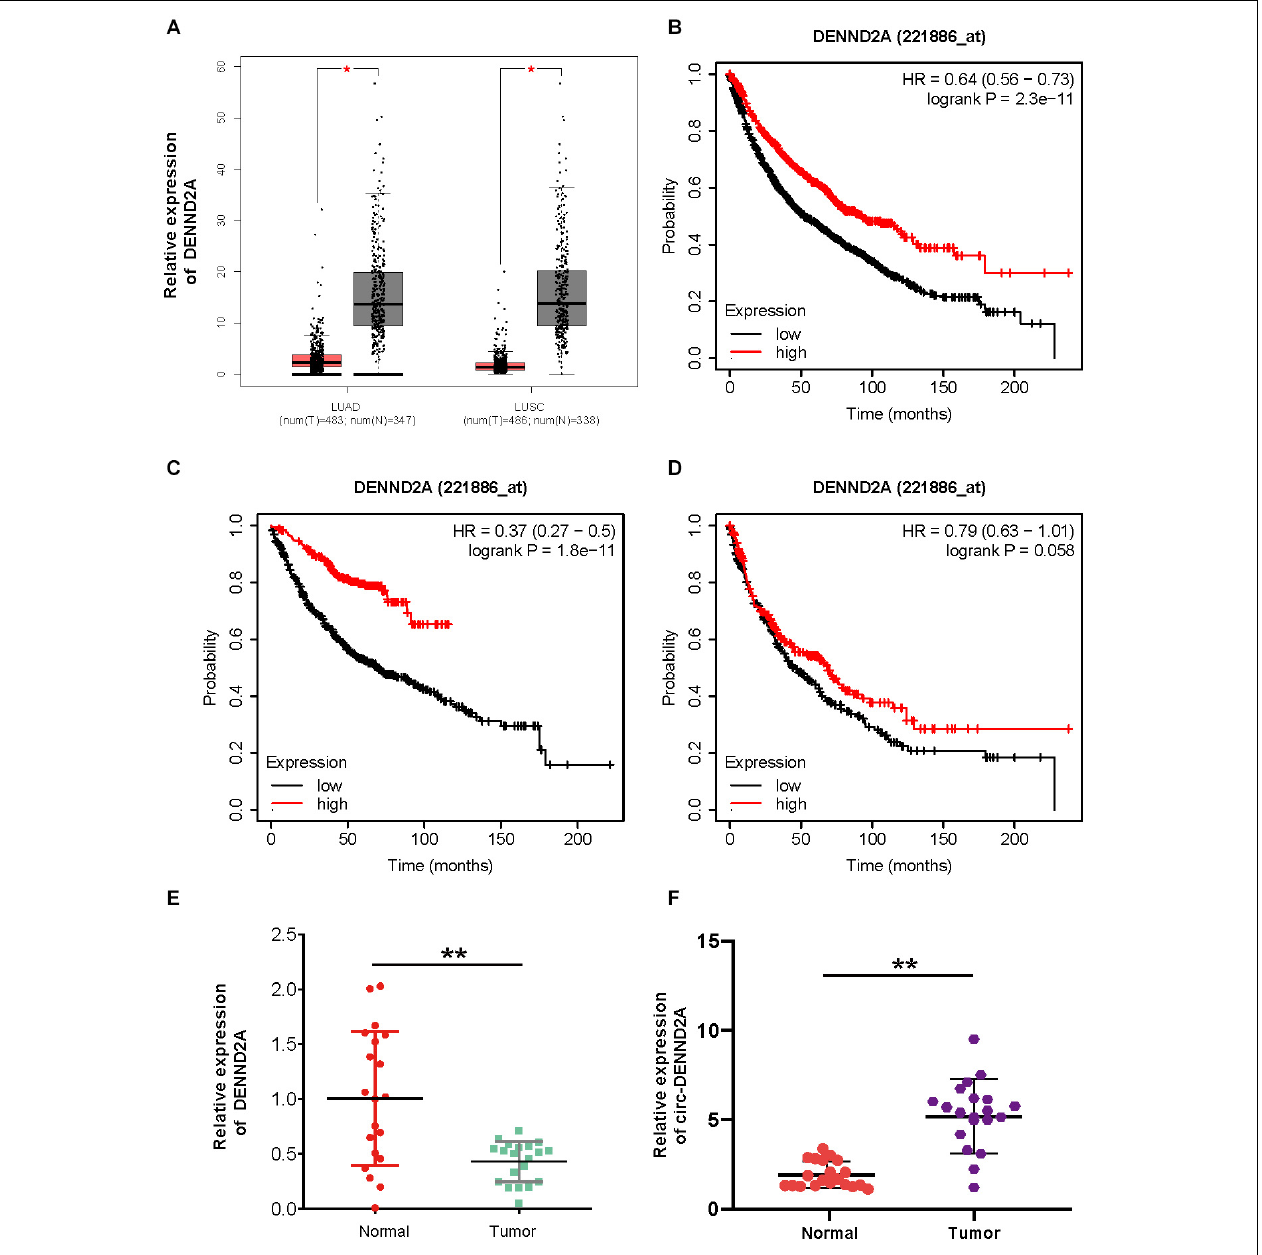
FIGURE 1 | CircDENND2A is up-regulated in NSCLC. (A) GEPIA database indicated DENND2A was up-regulated in NSCLC samples compared with normal tissues. (B–D) Kaplan–Meier analysis demonstrated that higher expression levels of DENND2A correlated to longer survival time in patients with NSCLC, LUAD, and LUSC by using Kaplan–Meier plotter database. (E,F) The high expression levels of DENND2A (E) and circDENND2A (F) in 20 paired NSCLC tissues by qRT-PCR (** P < 0.01). NSCLC, non-small cell lung cancer; GEPIA, Gene Expression Profiling Interactive Analysis; LUAD, lung adenocarcinoma; LUSC, lung squamous cell